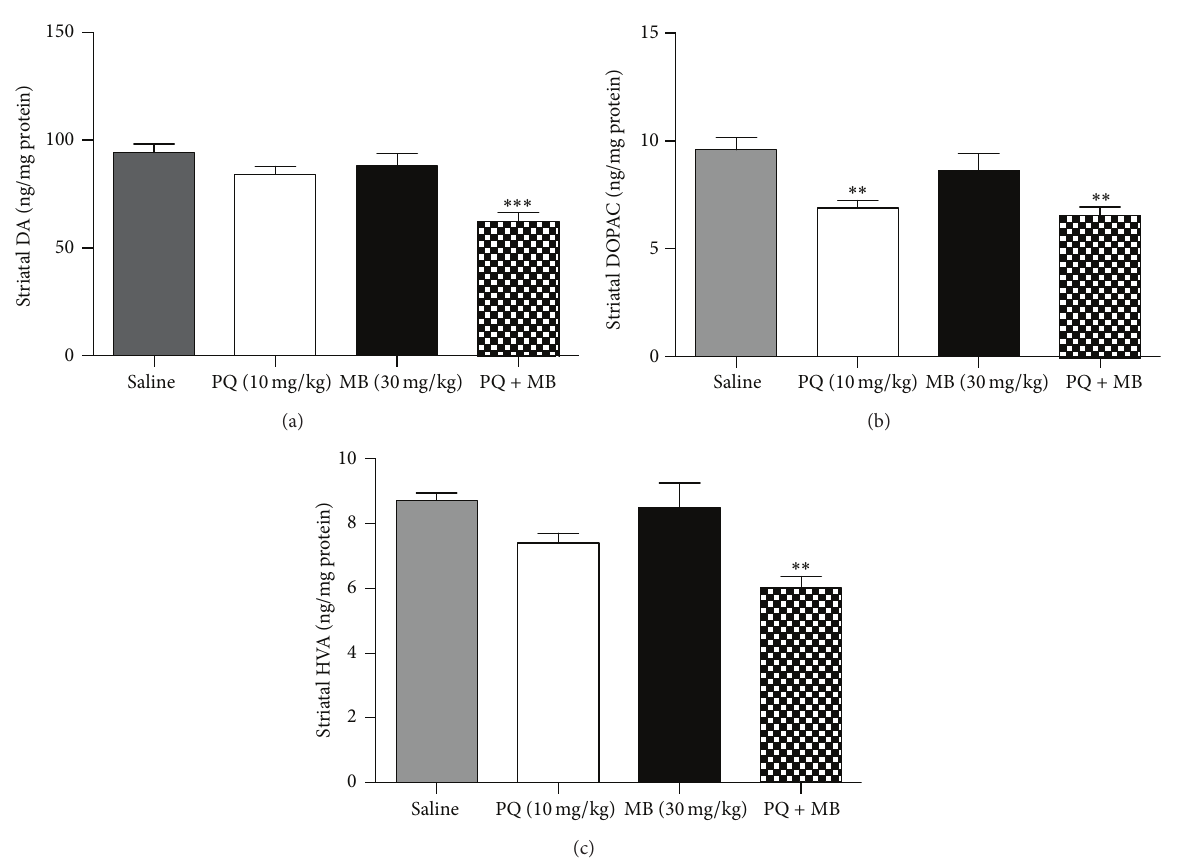
Figure 2: The combination of PQ and MB significantly decreases striatal DA, as well as its downstream metabolites. DA (a), DOPAC (b), and HVA (c) were quantified in striatal samples using HPLC and electrochemical detection. Data analyzed via one-way ANOVA and Dunnett’s post hoc test ( ∗∗ 𝑃 < 0.01 ; ∗ 𝑃 < 0.05 ). 𝑁 = 6–8 animals per treatment group.